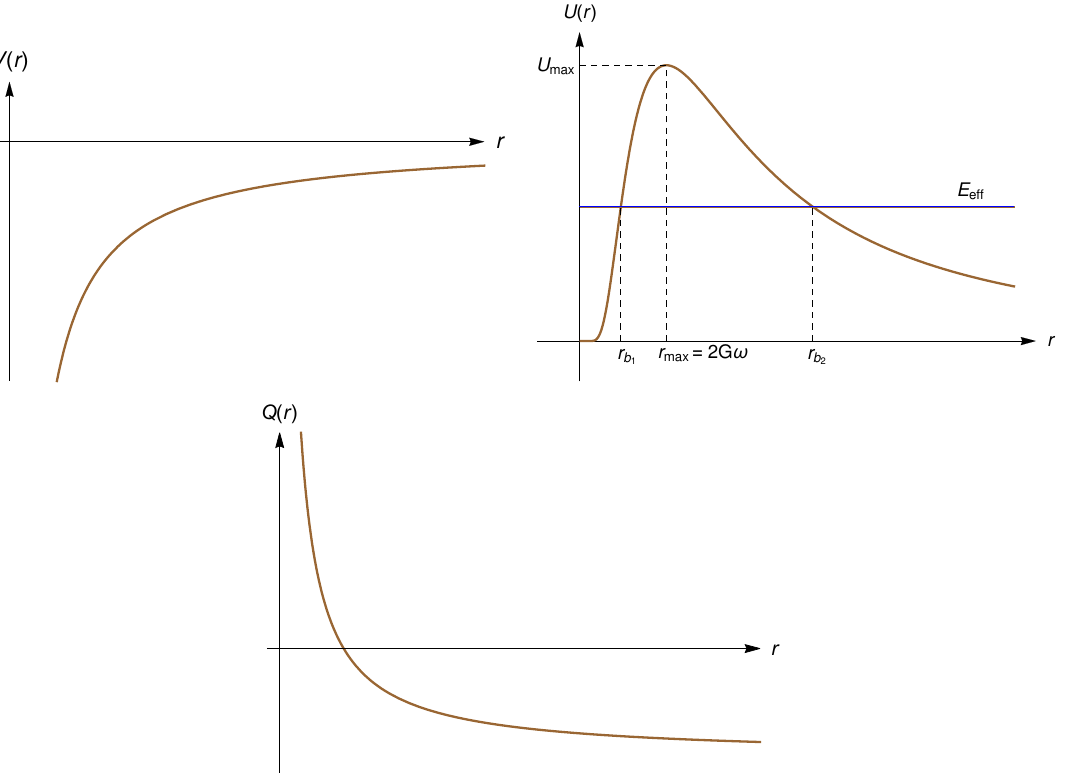
Figure 2 . Qualitative plots showing the potential V ( r ) and the corresponding effective potential U ( r ) for Einstein’s gravity. Notice that this case is very different from the one described in figure 1, because here the condition (i) is violated and the potential V ( r ) diverges at r = 0 . Therefore, the effective potential U ( r ) goes to zero at the origin. It also shows the plot of the function Q ( r ) . In this case, Q ( r ) does not possess a maximum, thus there is no local minimum for the effective potential U ( r ) at non-zero r . If U max > E eff with r 0 < r b 1 (or if U max < E eff ) the particles will reach r = 0 where maybe the “semi-classical” approximation based on eqs. (2.5)–(2.7) does not hold anymore. As proposed in [1], in this situation quantum effects may be responsible to bound the system. On the other hand, if U > E , but r , the particles will scatter at the distance r going max eff 0 > r b 2 b 2 afterwards to the